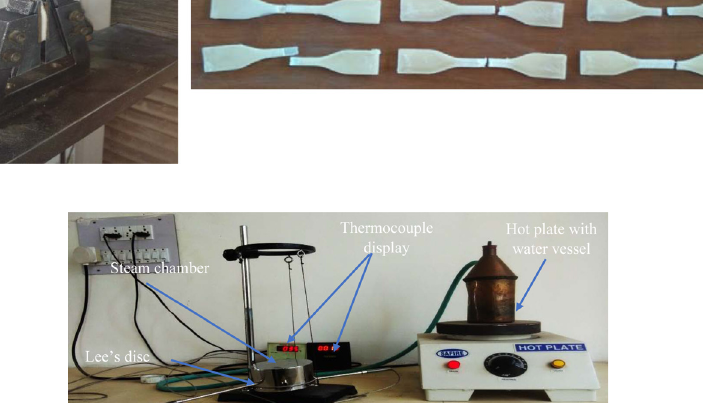
Figure 8. Experimental view of UTM and fractured parts by tensile